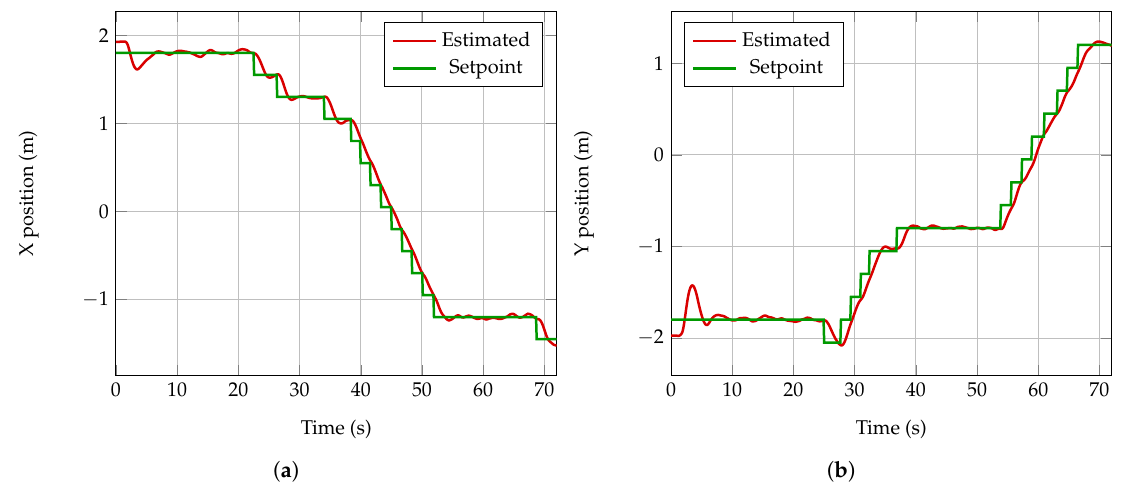
Figure A1. UAV position response for a smooth traversed path for ( a ) x and ( b ) y axes.